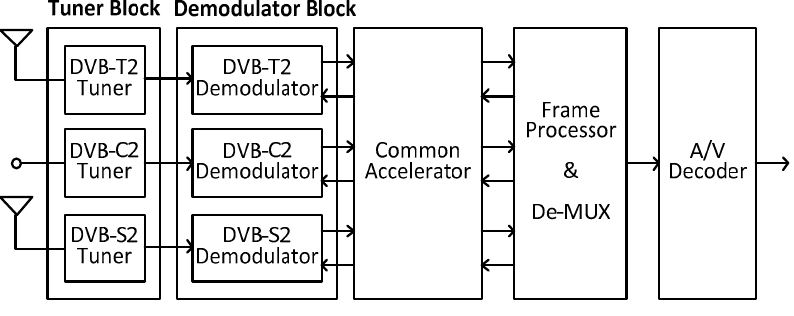
Figure 3. Block diagram of DVB-X2 receiver.